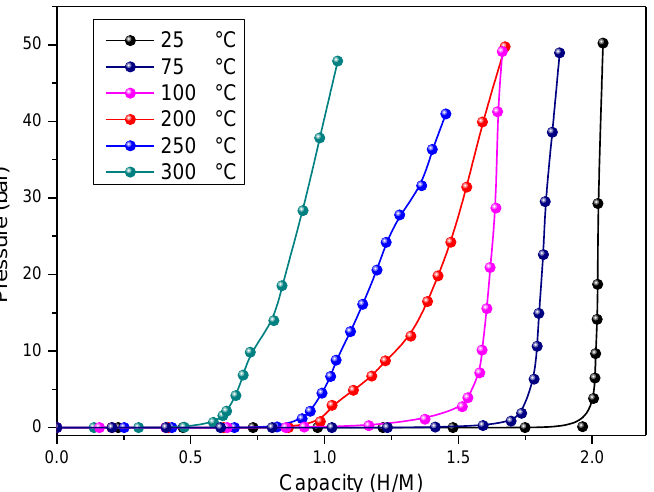
Figure 3. Pressure–Composition Isotherms at 25 °C, 75 °C, 100 °C, 200 °C, 250 °C and 300 °C of